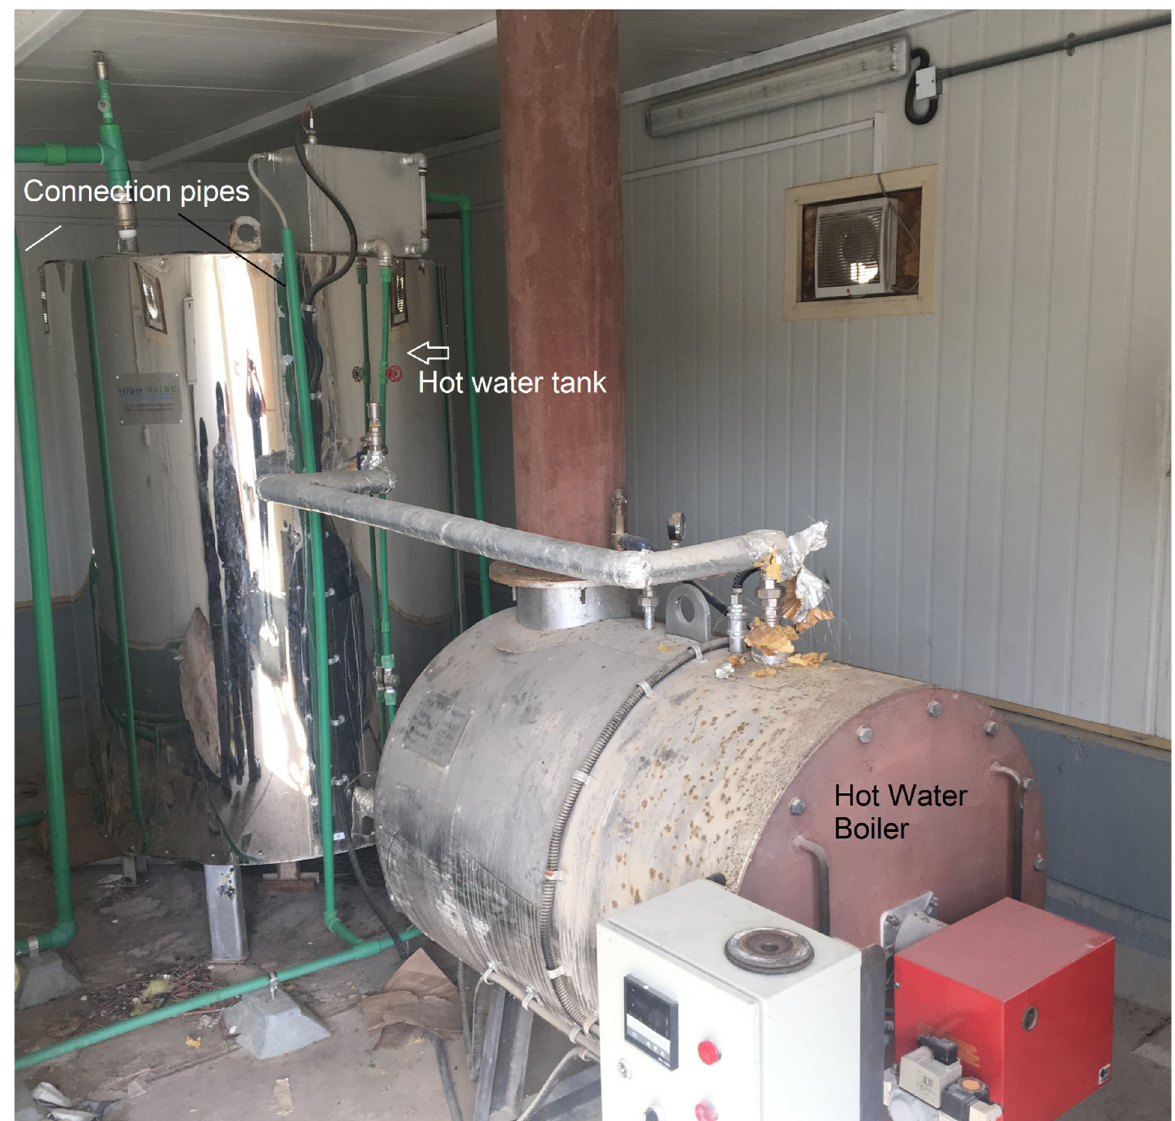
Figure 5. Hot water tank and LPG boiler. In the image, green pipes, connecting the integrated machine to the hot water tank, can be seen.